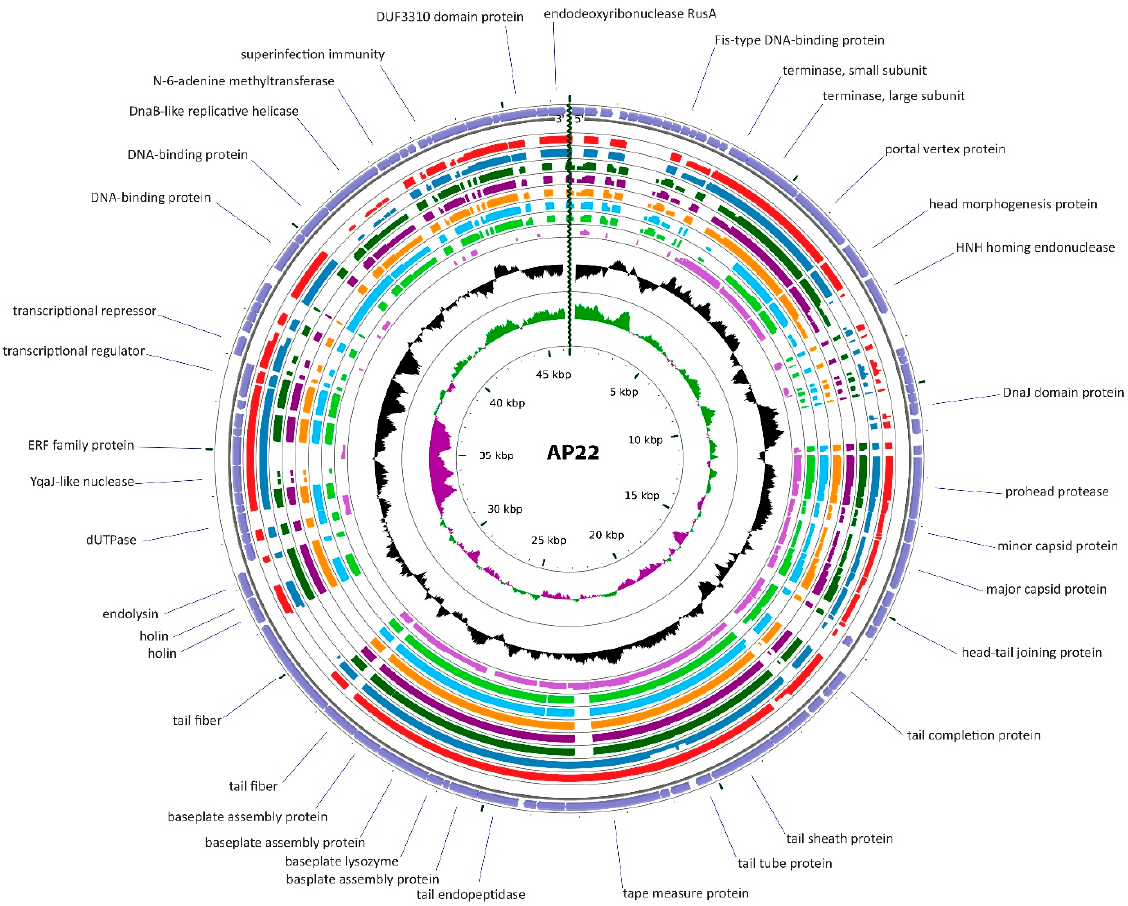
Figure 5. Comparative genome map of AP22 and the Cluster B phages. AP22 was used as the reference genome due to its designation as the type species of the genus Ap22virus. The inner rings display tBLASTx comparisons to WCHABP12 (red), WCHABP1 (dark blue), YMC-11/12/R2315 (dark green), YMC-13-01-C62 (dark purple), YMC-11/12/R1215 (orange), LZ35 (light blue), IME-AB2 (light green) and phiAC-1 (light purple). GC content is depicted in black while positive and negative cumulative GC skew is shown as green and purple, respectively.